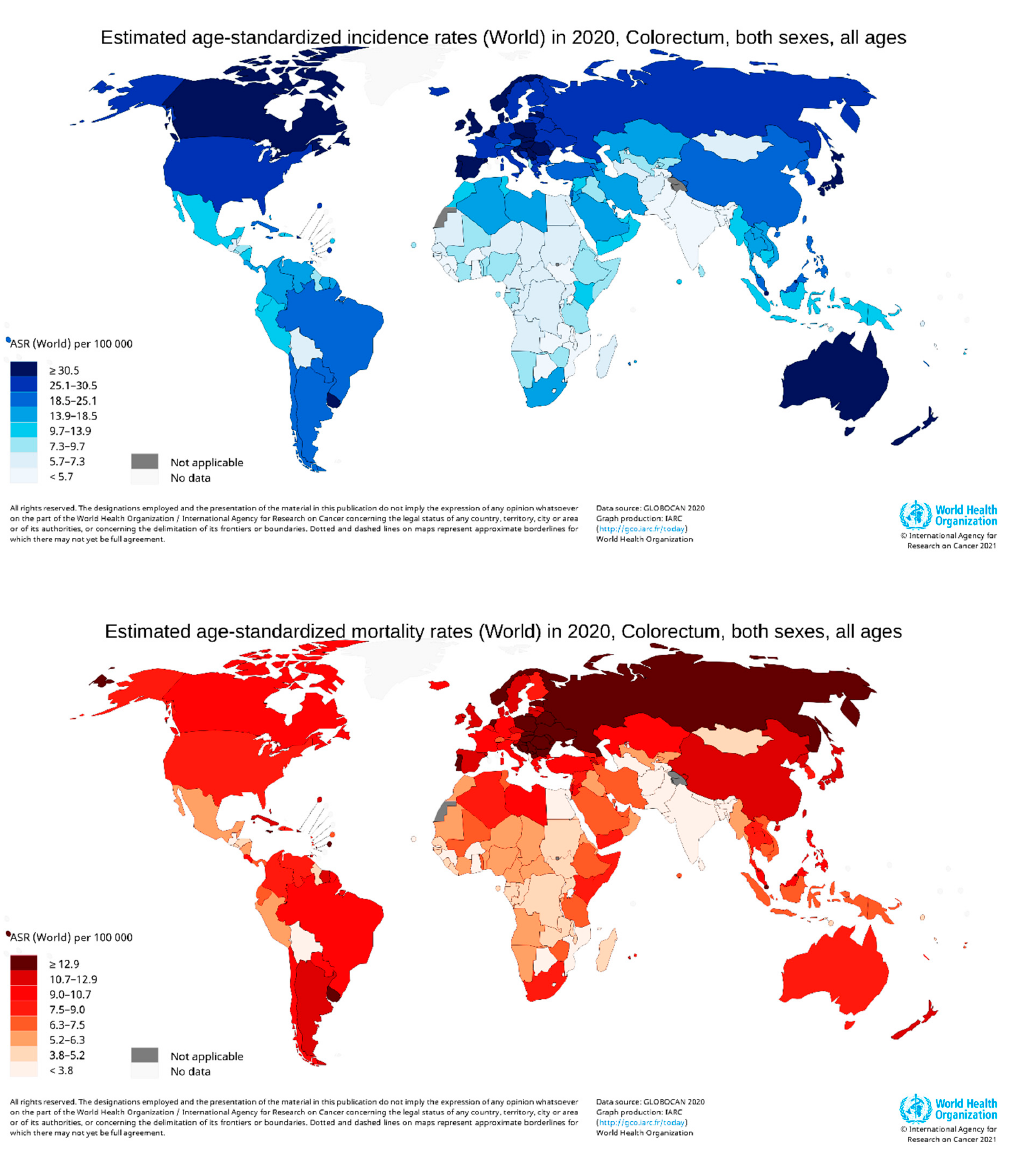
Figure 3. Map showing the global distribution of estimated age-standardized incidence rates ( top ) and mortality rate ( bottom ) of CRC in 2020 for both sexes and all ages. (Reproduced from GLOBOCAN [25] with permission). Table 1. World CRC estimated age-standardized incidence and mortality rates in 2020 (all ages).